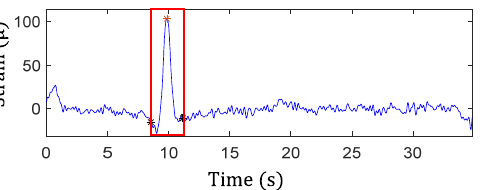
Figure 18. Identified traffic events and WOIs from strain, 𝐹(𝑡) , measurement under a single traffic event.